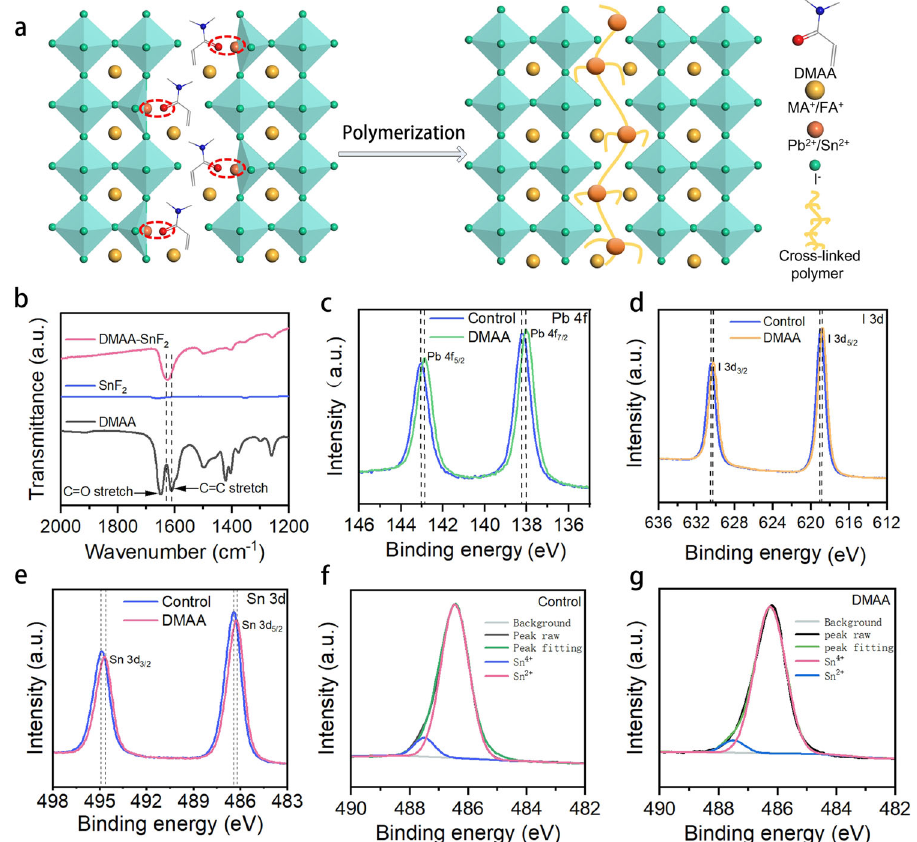
Fig. 2 Interactions between perovskite and DMAA. a Schematic illustration of the interaction between DMAA and perovskite. b FTIR spectra of DMAA, SnF 2 and DMAA-SnF 2 after thermal annealing. XPS spectra of ( c ) Pb 4 f, ( d ) I 3d, and ( e ) Sn 3d for the perovskite fi lms. XPS spectra of perovskite fi lm without ( f ) and with ( g )